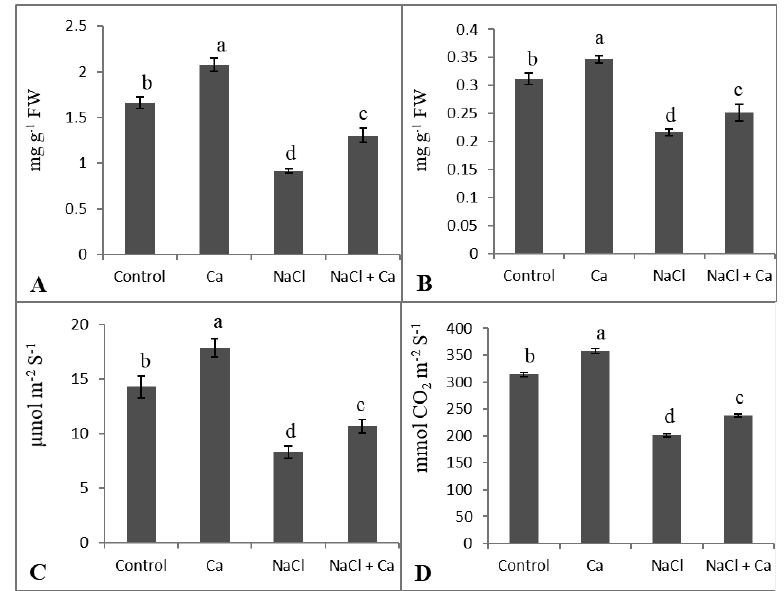
Fig. 2: Effect of salinity stress (100 mM NaCl) on (A) total chlorophylls, (B) carotenoids, (C) photosynthetic rate and (D) stomatal conductance in soybean ( Glycine max L.) with and without calcium supplementation. Data is mean (±SE) of three replicates and bars with different letters denote significant difference at P ≤